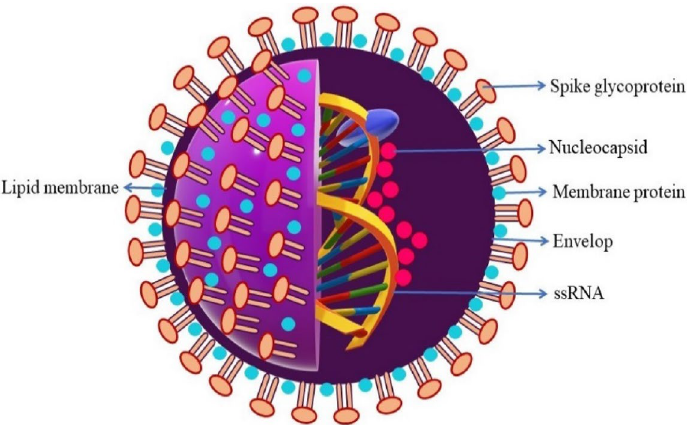
Figure 1. Schematic diagram of SARS-CoV-2.